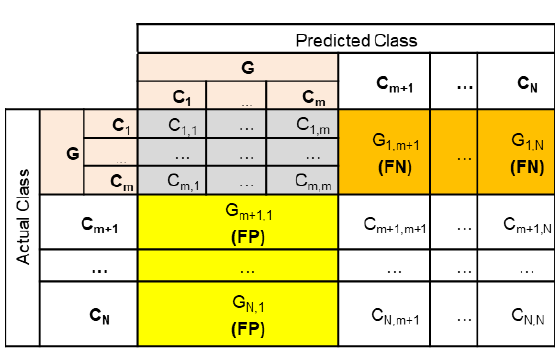
Figure 2. Confusion matrix class grouping